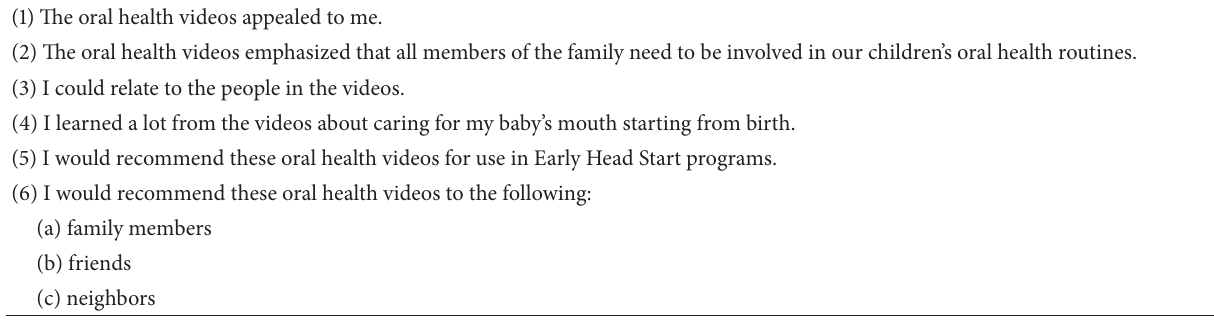
Table 5: Posttest consumer satisfaction—5 point Likert scale, 8 items.